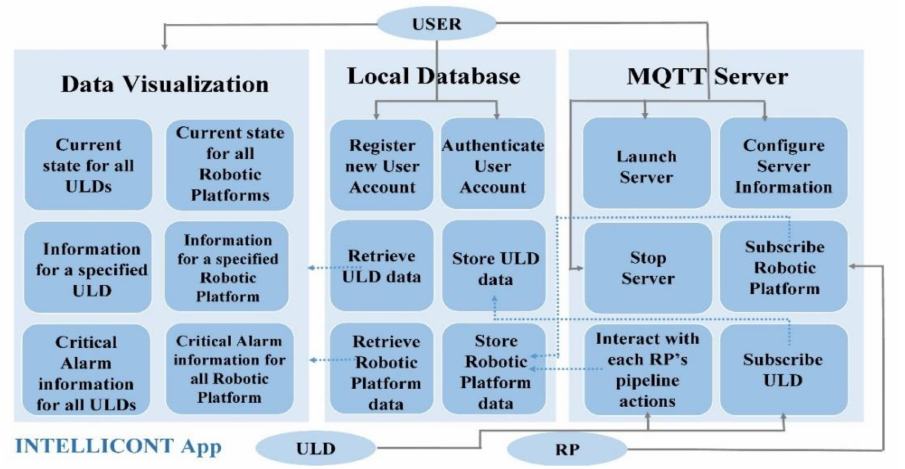
Figure 4. HMI application use cases